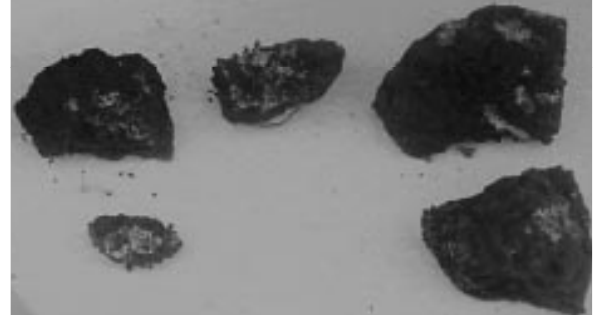
Figura 2. Partículas acumuladas de calcário na superfície de agregados do solo encontrados na última camada (16-20 cm) da coluna.